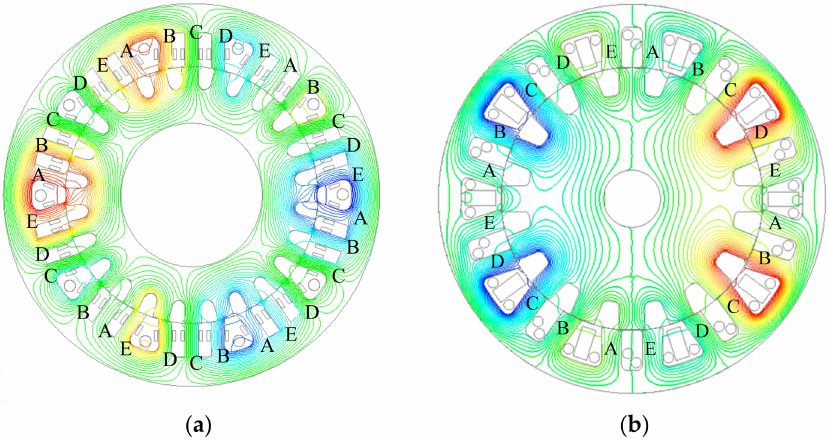
Figure 1. Two topology of the five-phase wound-field doubly salient generators (WFDSGs). ( a ) 30 / 24-pole; ( b ) 20 /